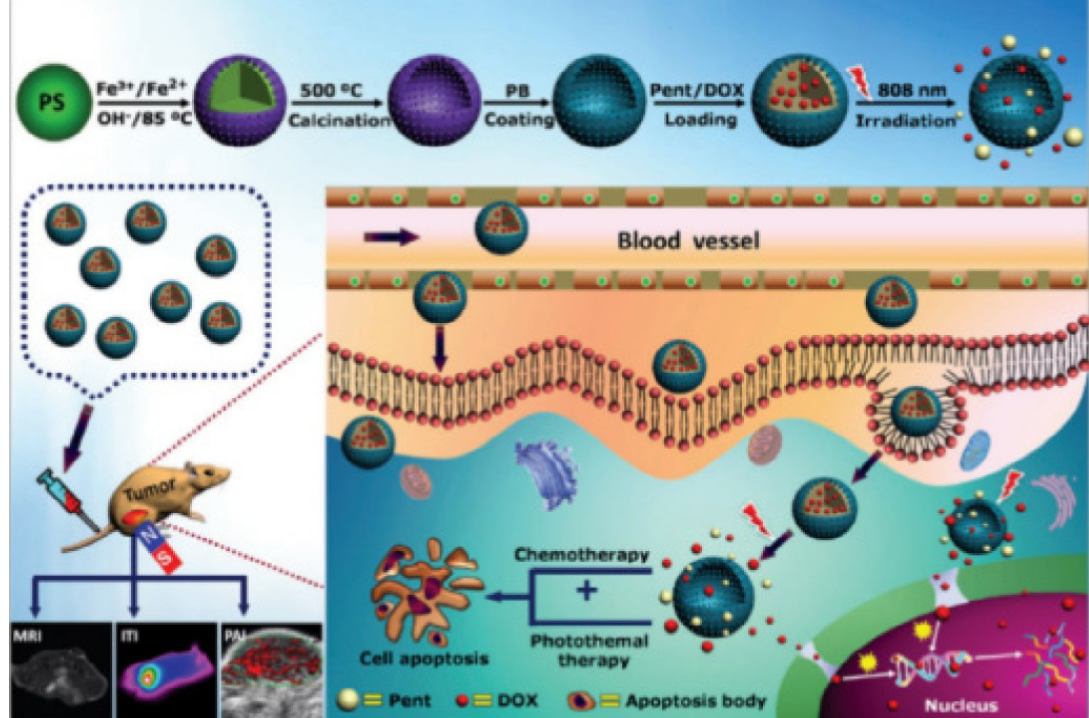
Scheme 3. Schematic illustration of the design and synthesis of HMNP-PB@Pent@DOX for NIR guided synergetic chemo-photothermal tumor therapy with trimodal imaging in vivo. Reprinted with permission